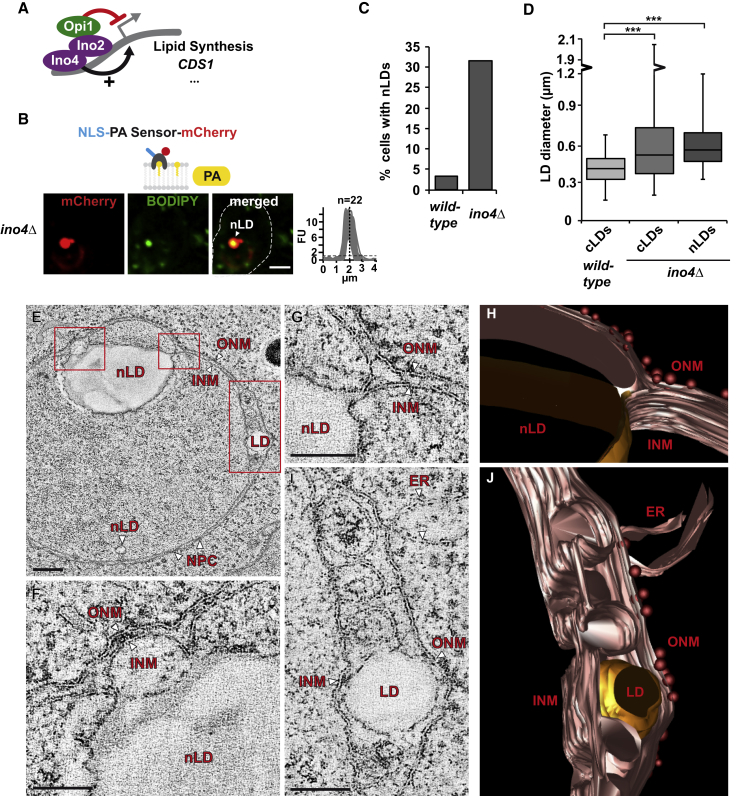
Nuclear Lipid Droplets Are Generated Directly from the INM(A) Cartoon of lipid synthesis control by the Ino2/Ino4 transcriptional activator and the Opi1 transcriptional repressor. CDS1 and several other genes involved in phospholipid synthesis (e.g., INO1, CHO1, CHO2, OPI3, PSD1) are controlled by these factors.(B) Live imaging of ino4Δ cells expressing the NLS-PA-mCherry sensor. Lipid droplets are stained with BODIPY. Sensor fluorescent intensity was quantified across the nucleus as in Figure 2B. n = number of randomly selected cells. Scale bar, 2 μm.(C) Quantification of cells with nLDs; 150 wild-type and 400 ino4Δ cells were analyzed.(D) Comparison of nuclear and cytoplasmic lipid droplet diameter in the indicated strain backgrounds. Box-whisker plot showing median, interquartile range, and minimum and maximum value. ∗∗∗p value <0.001 was determined by Wilcoxon signed-rank test.(E–J) Transmission electron microscopy (TEM) and 3D reconstruction of the nuclear envelope in ino4Δ cells. (F) and (G) correspond to the boxed areas in the upper part of (E) and show INM-nLD membrane bridges. (I) shows a magnification of INM evaginations seen on the right side of (E). (H) and (J) are 3D reconstructions of (G) and (I), respectively. The ONM is studded with ribosomes (red spheres). See Video S3 for an animated 3D model. Scale bar, 200 nm (E) or 100 nm for images (F), (G), and (I).See also Figure S5 and Video S3.